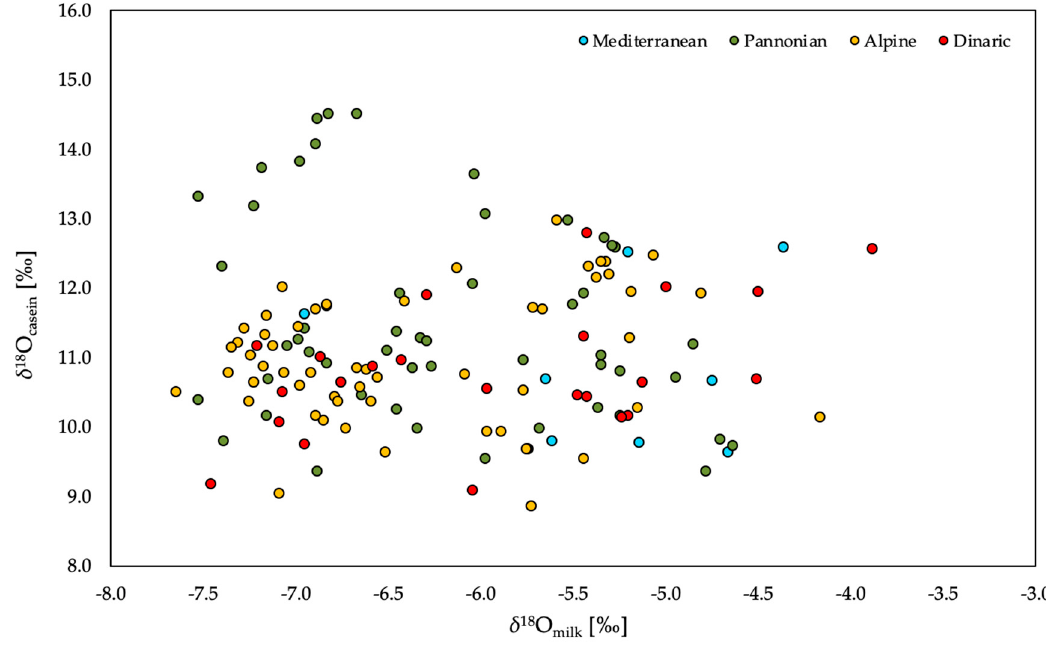
Figure 3. The relationship between δ 18 O milk and δ 18 O casein values in milk in relation to the region of production.